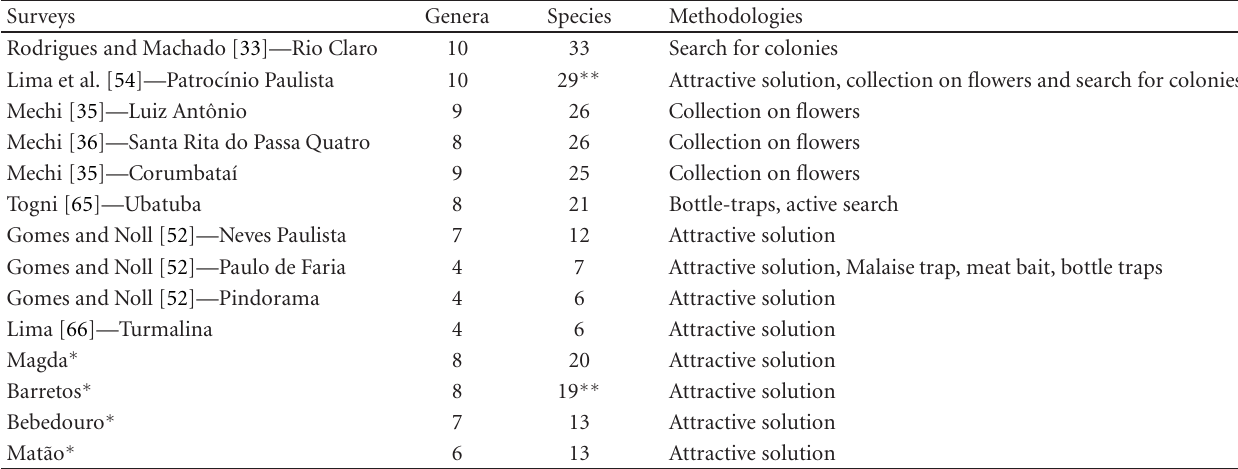
Table 3: Comparison of the richness of social wasps species of the present work (marked with a ∗ ) with recent surveys done in S˜ao Paulo